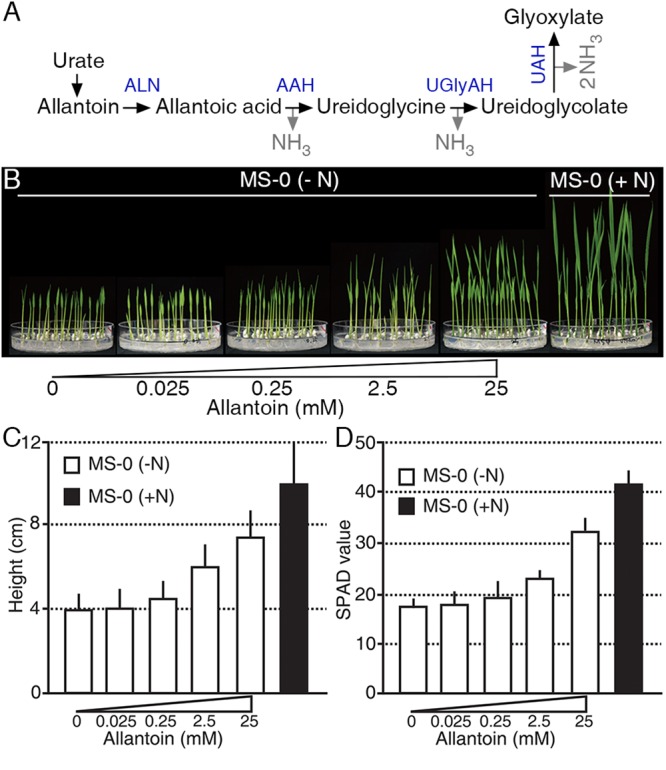
Allantoin is used as an N source in rice. (A) The allantoin catabolic pathway. A molecule of allantoin is converted to glyoxylate and produces four molecules of NH3. ALN, ALLANTOINASE; AAH, ALLANTOATE AMIDOHYDROLASE; UGlyAH, UREIDOGLYCINE AMINOHYDROLASE; UAH, UREIDOGLYCOLATE AMINOHYDROLASE. (B) Phenotype (9-day-old), (C) height (9-day-old), and (D) SPAD value (16-day-old) of rice plants grown on growth media with various allantoin concentrations as the sole N source. Values represent the mean + SD of two biological replicates. Each test used 20 plants for each allantoin concentration.